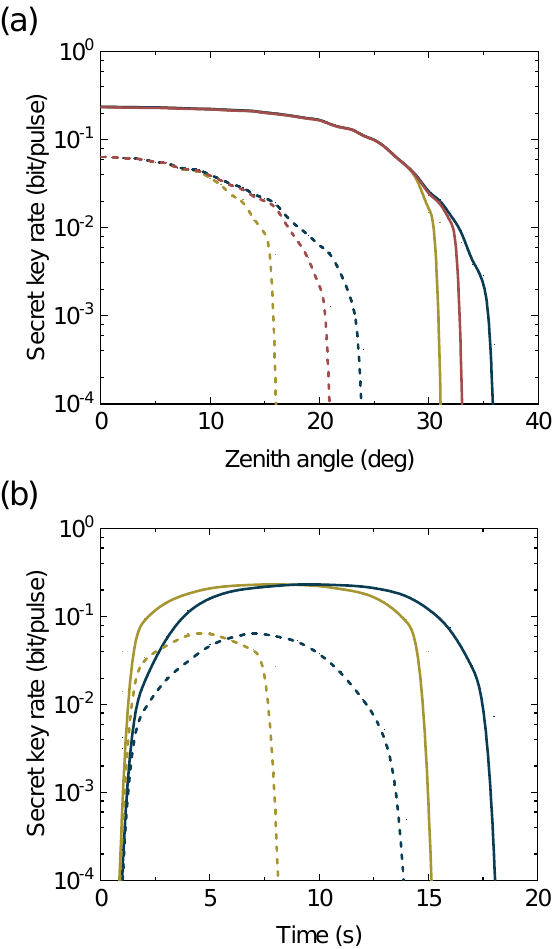
Figure 5. Secret key rate as a function of ( a ) zenith angle and ( b ) communication time during a single communication cycle. The blue, red, and yellow lines represent the case of ZPC-based protocol, SPC-based protocol, and coherent-state protocol, respectively. Solid lines and dashed lines represent two situations using the satellite altitude H = 100 km and H = 120 km,